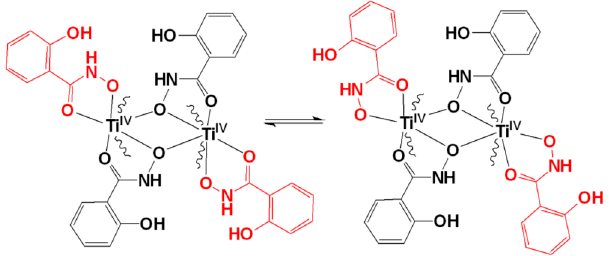
Scheme 3. Two possible isomers that might be formed in CD 3 OD solutions of 1